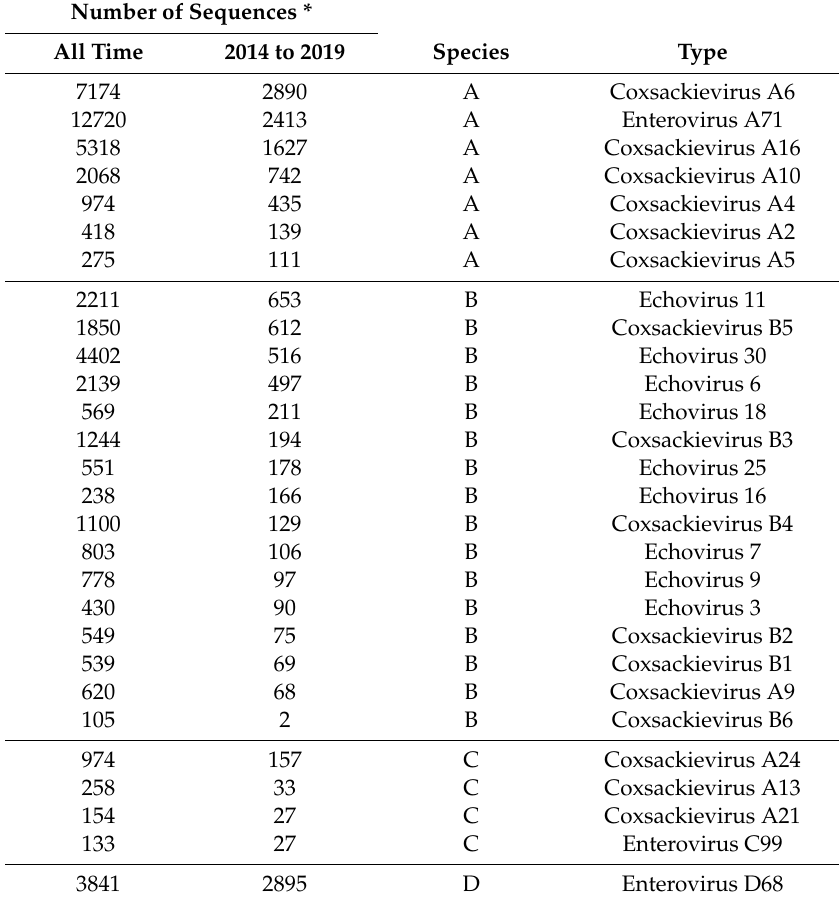
Table 1. Number of genomic sequence records for the most common non-polio